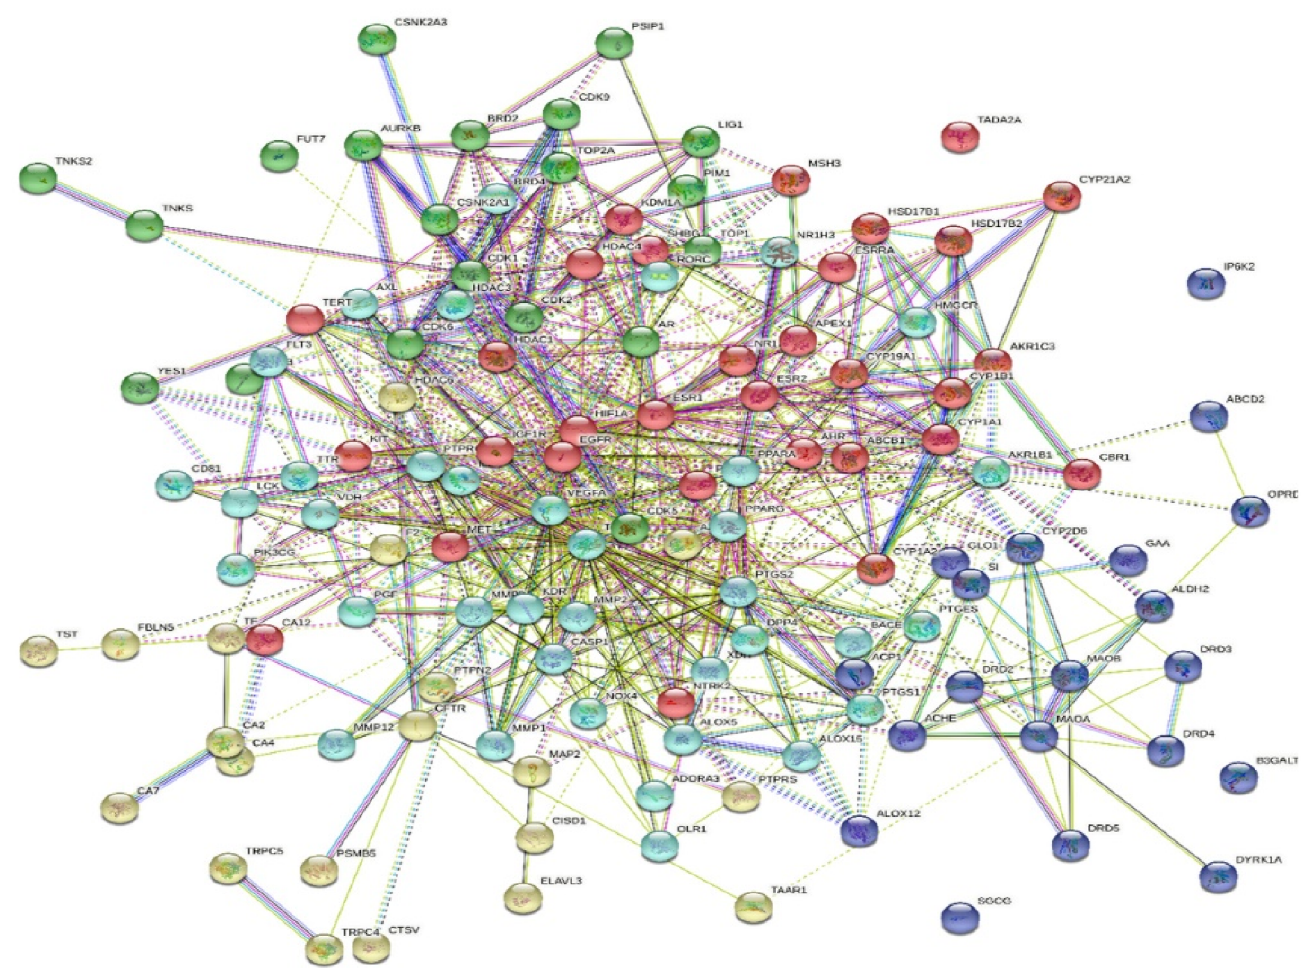
Figure 6. PPI of the identified targets related to the identified compounds of Olea europaea L. cv. Picual extract; the interaction is shown in five clusters, each colour represent a cluster.